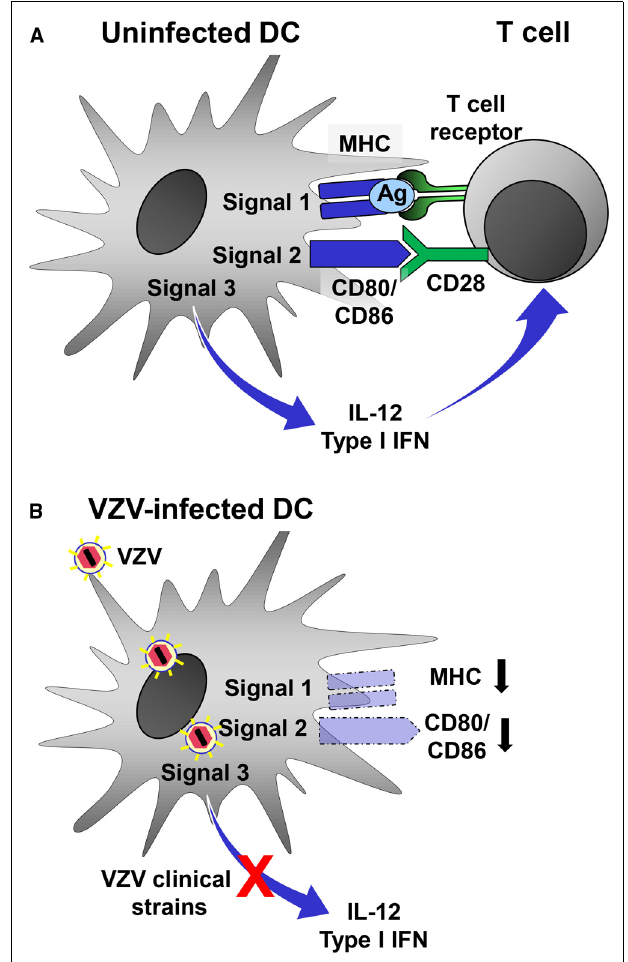
FIGURE 2 | Evasion of DC function by VZV. (A) Stimulated uninfected DCs can induce efficient antiviral Th1-like adaptive immune responses by providing three signals to antiviral T cells. Virus-derived antigen (Ag) is presented by MHC molecules (signal 1) and recognized by the T cell-receptor (TCR) on T cells. Costimulatory molecules such as CD80 and CD86 interact with CD28 expressed by T cells (signal 2). DCs integrate stimuli received through a combination of different PRRs and release type I IFN and IL-12. (B) VZV-infected DCs are no longer able to deliver signal 1–3 to antiviral T cells. MHC as well as costimulatory molecules are downregulated. Moreover, VZV clinical strains but not the vaccine strain interfere with PRR-induced innate signaling resulting in the inability to release type I IFN and IL-12. Together, these functional changes prevent VZV-infected DCs to mount an effective antiviral Th1-like adaptive immune